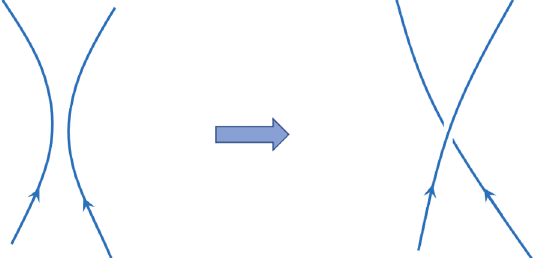
Figure 10. A bulk twist operator exchanges open string segments and implements a 2 → 2 interaction of open strings as well as closed string joining/splitting, and open+closed ↔